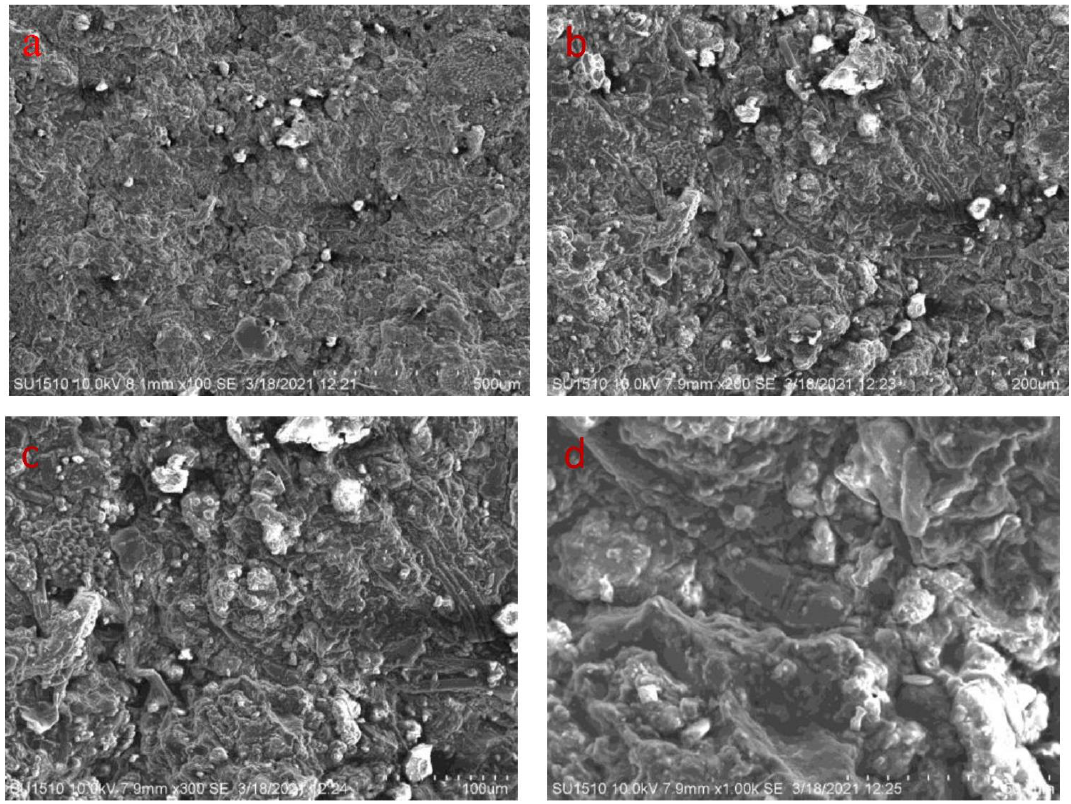
Figure 9. SEM images of 10% fenugreek bio-composite at ( a ) 500 µm ( b ) 200 µm ( c ) 100 µm ( d ) 50 µm.